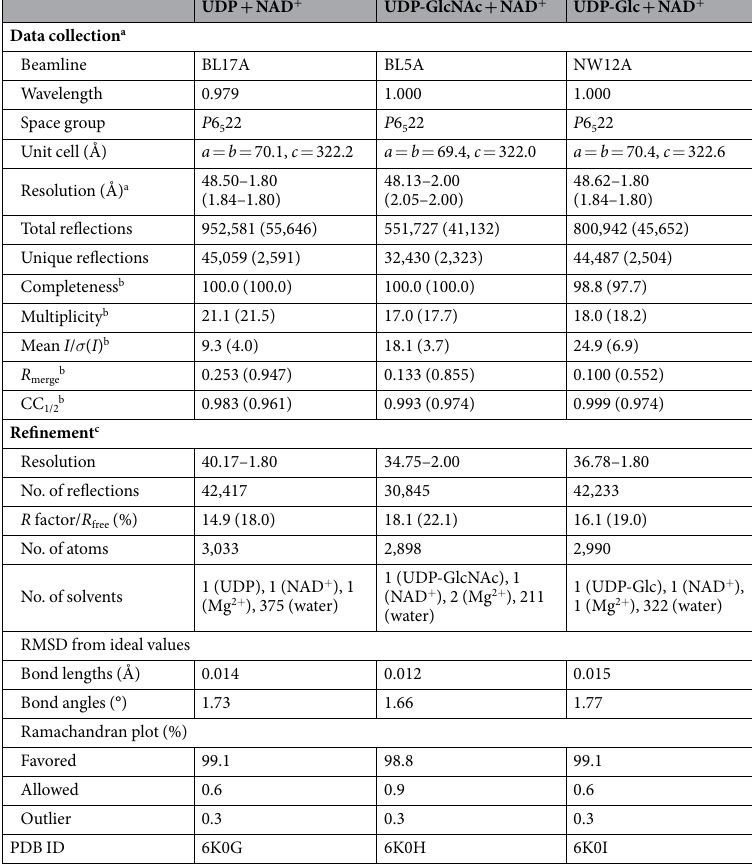
Table 2. Data collection and refinement statistics. a Calculated using XDS. b Values in parentheses are for the highest resolution shell. c The structures were refined using diffraction datasets processed by